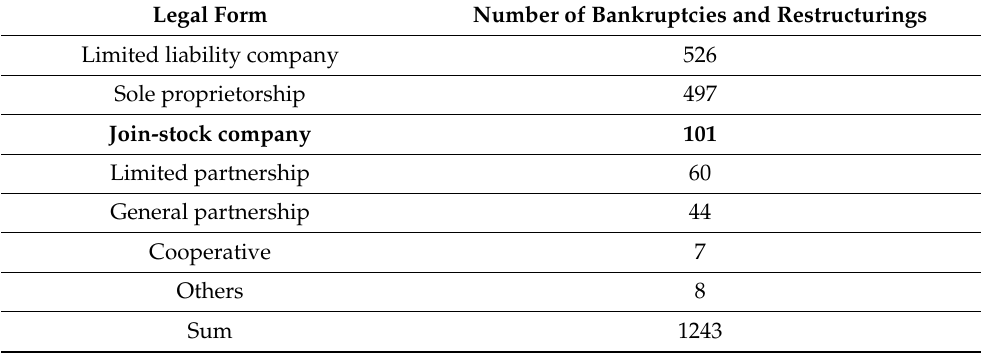
Table 2. Bankruptcies and restructurings in Poland by legal forms—the year